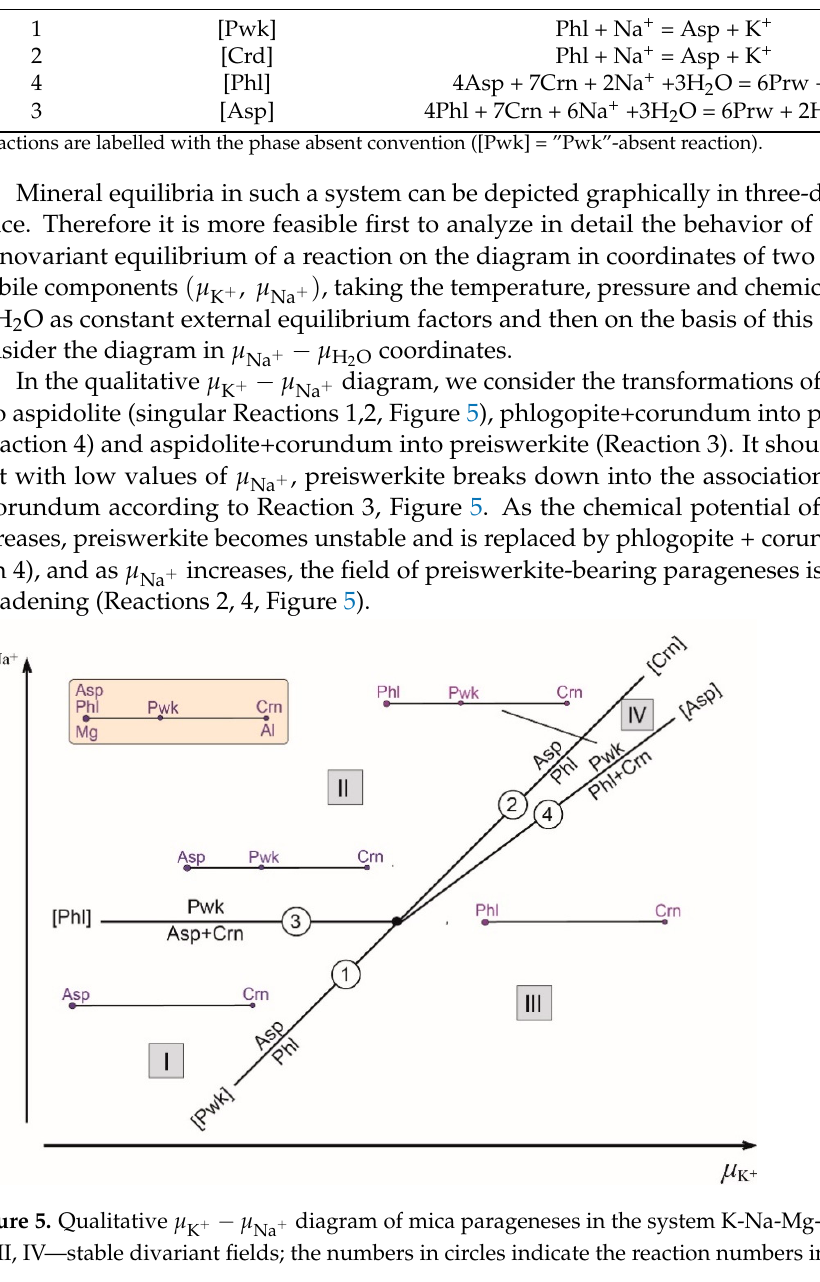
Table 4. Equations of chemical reactions occurring on lines of monovariant equilibrium. N Lines *